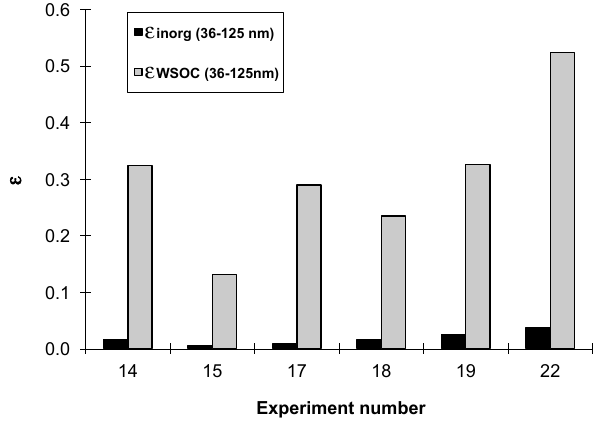
Fig. 5. Volume fraction of inorganic ions (black bars) and water soluble organic carbon (WSOC; gray bars) estimated from impactor samples. Fuel types are for the individual experiments are: Hard- wood (14, 19); Softwood (15, 17); Softwood and green needles (18, 22).